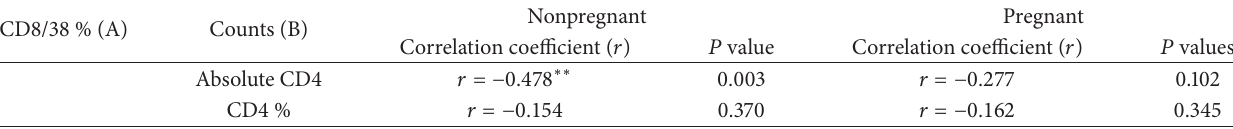
Table 4: Relationship between CD8/HLA-DR, CD8/38, and the CD4 + cell counts (statistical analysis by Pearson correlation (Sig. (2 tailed))). Nonpregnant Pregnant CD8/HLA-DR % (A) Counts (B) Correlation coefficient ( 𝑟 ) 𝑃 value Correlation coefficient ( 𝑟 ) 𝑃 values CD8/38 % 𝑟 = 0.999 ∗∗ < 0.001 𝑟 = 0.876 ∗∗ < 0.001 Absolute CD4 𝑟 = −0.470 ∗∗ 0.004 𝑟 = −0.056 0.746 CD4 % 𝑟 = −0.153 0.374 𝑟 = −0.022 0.898